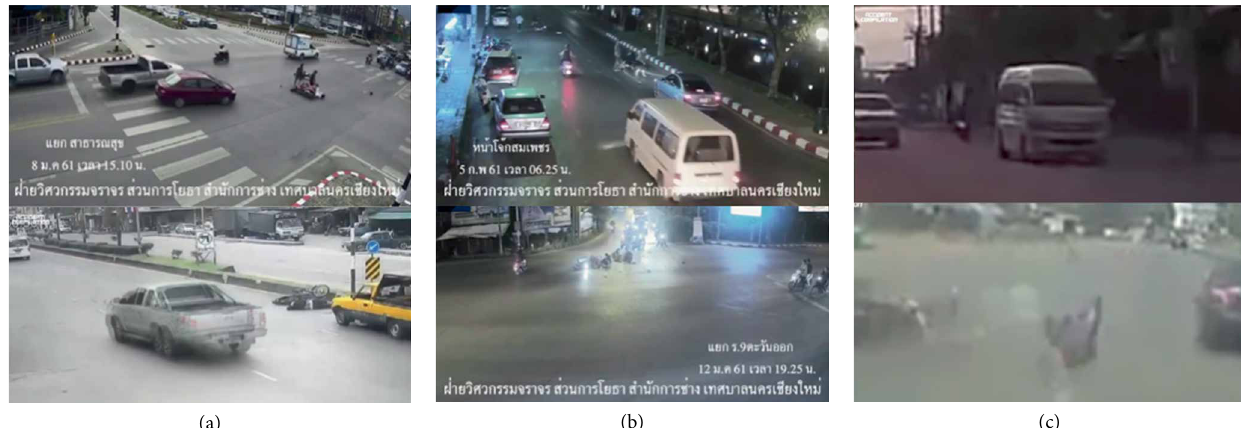
Figure 4: Sample frames from the video dataset used to evaluate the accident. The dataset contains videos of accidents during the various environmental conditions such as (a) daytime (b) night (c) rain or fog, as well as from different cameras and view angles.